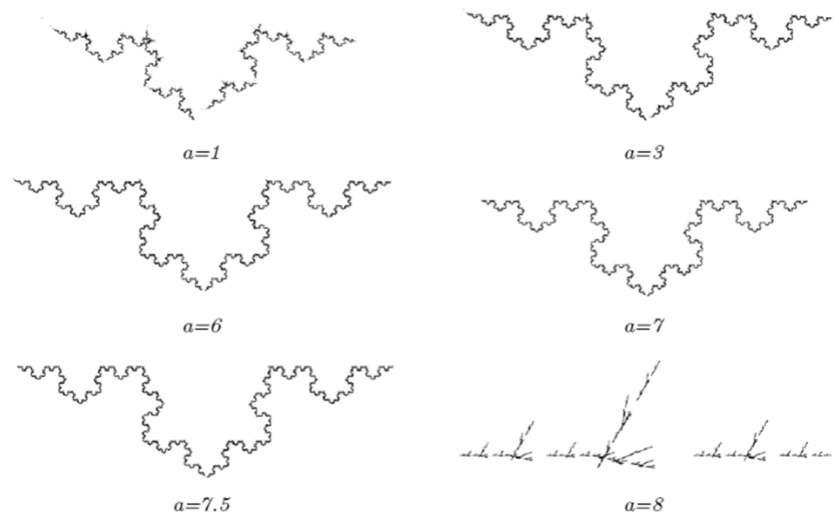
Figure 5. Some last images of fractals of the second kind for the neural network with different growth rates.